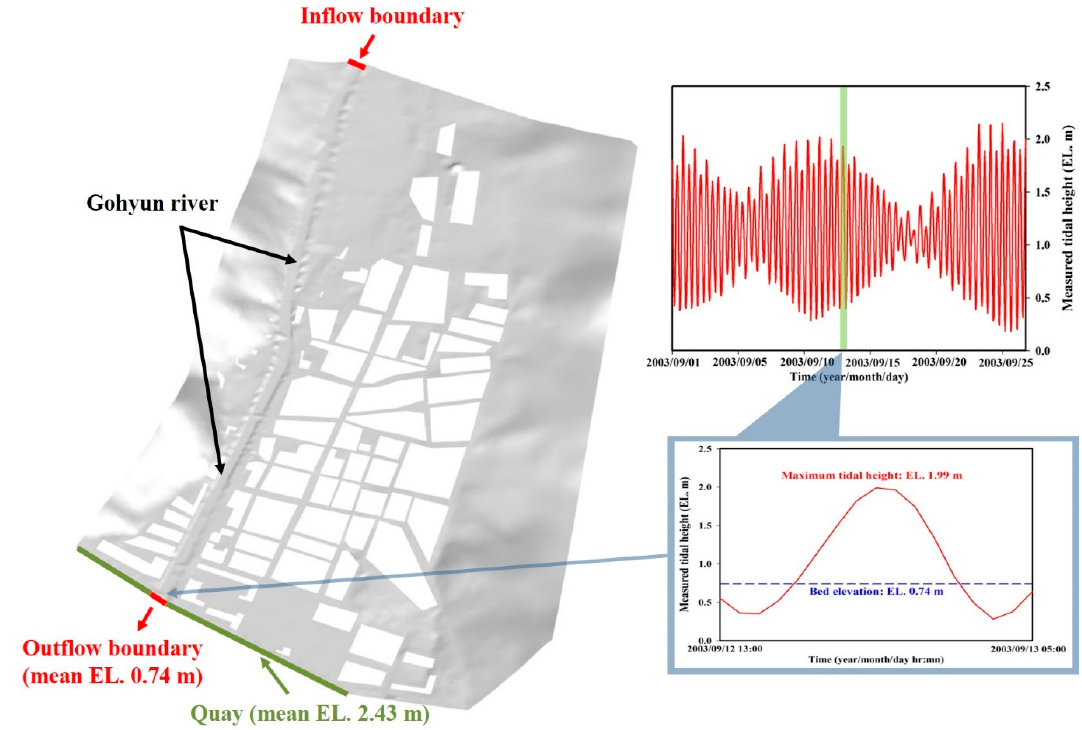
Figure 7. Temporal variation in the tidal level imposed on the outflow boundary.